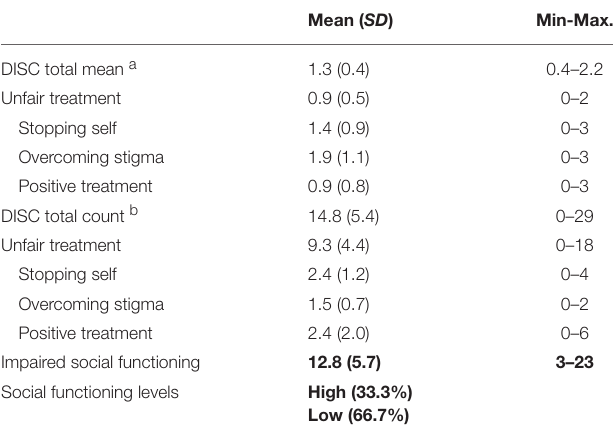
TABLE 2 | Stigma and social function scores.